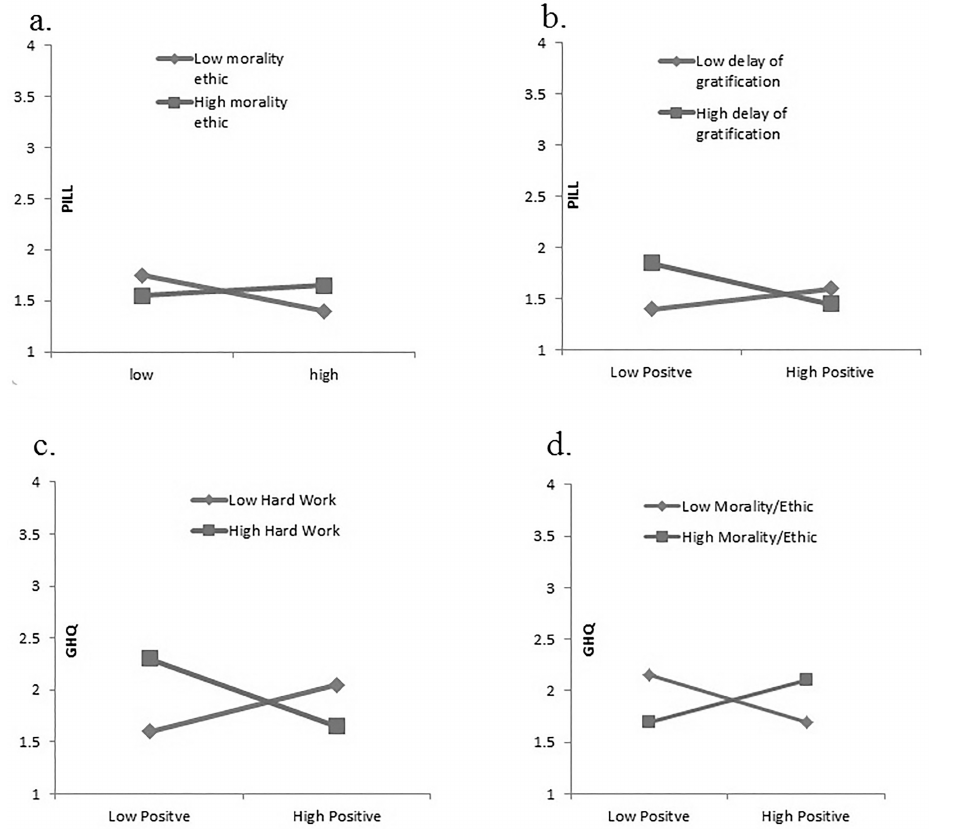
Figure 1. The Moderating role of work beliefs in the relationship between positive work interruption, wellbeing and general